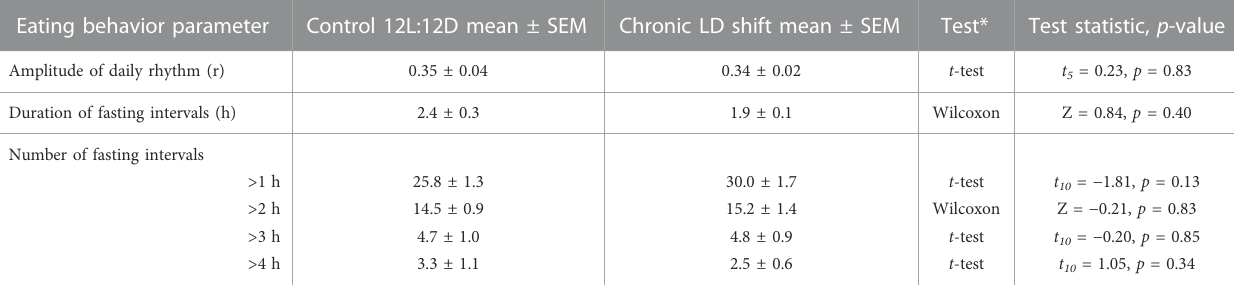
TABLE 3 Descriptive statistics and statistical analyses of eating behavior in female ApoE − / − mice. *Paired Student ’ s t -tests were two-tailed for data that were normally distributed and had equal variances, while Paired Sample Wilcoxon Signed Rank tests were used if data were not normally distributed or did not have equal variances, n =